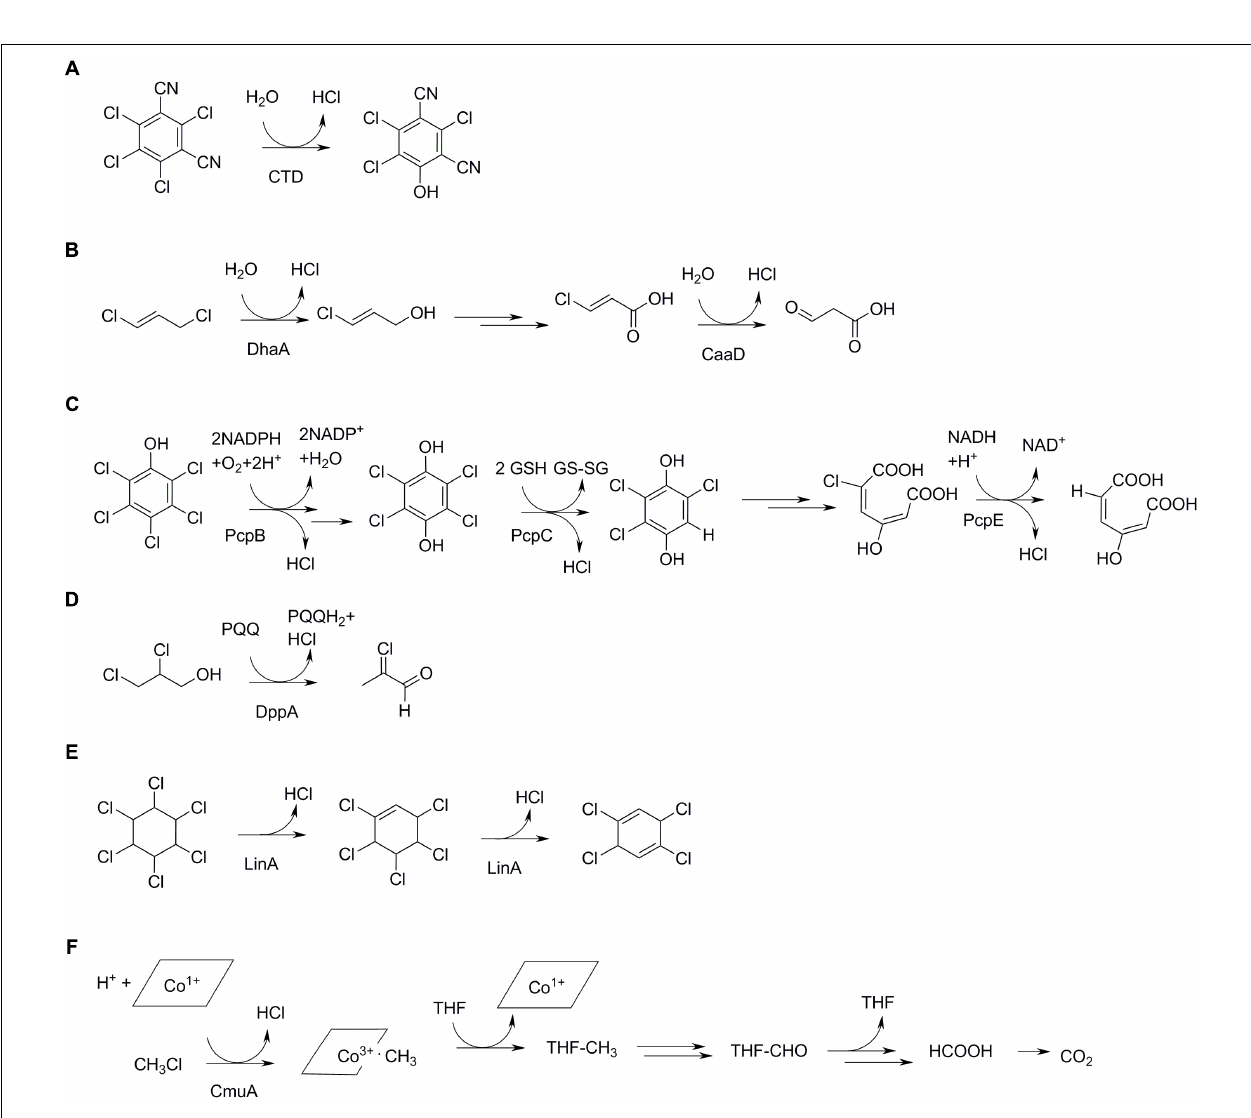
FIGURE 4 | Productive routes for utilization of selected organochlorine compounds in bacteria. (A) Initial step in chlorothalonil degradation, catalyzed by a dehalogenase (CTD) (Liang et al., 2011). (B) 1,3-dichloropropene degradation by Pseudomonas pavonaceae (Poelarends et al., 1998). The initial dehalogenase (DhaA) is found in haloalkane-degrading bacteria from different geographic regions, whereas the second dehalogenase (CaaD) is unrelated and rare (Poelarends et al., 2000). (C) Pentachlorophenol metabolism by an initial monooxygenase (PcpB) reaction and two reductive reactions, the first one (PcpC) involving a glutathione transferase, and the second one (PcpE) involving an NADH-dependent reductase (Kiefer and Copley, 2002; Hlouchova et al., 2012). (D) Degradation of 2,3-dichloropropanol via the highly reactive intermediate 2-chloroacrolein (Arif et al., 2012). (E) The insecticide hexachlorohexane undergoes two initial dechlorinations by elimination by a dehalogenase (LinA). (F) Aerobic methylchloride metabolism involving a corrinoid cofactor of the methyltransferase (CmuA) and tetrahydrofolate (THF) as methyl acceptor (Stourman et al.,